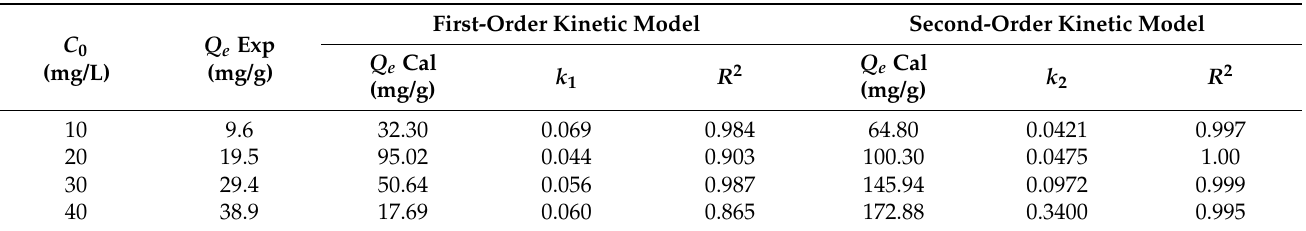
Table 2. Kinetic model parameters for methylene blue adsorption with the increase in initial